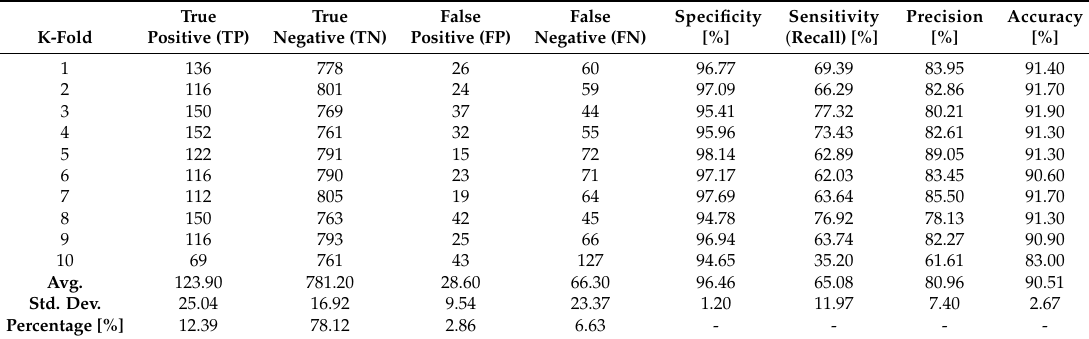
Table 7. 10-Fold Cross-validation of the proposed ANN model by using the proposed dataset. True True False False Specificity Sensitivity Precision Accuracy